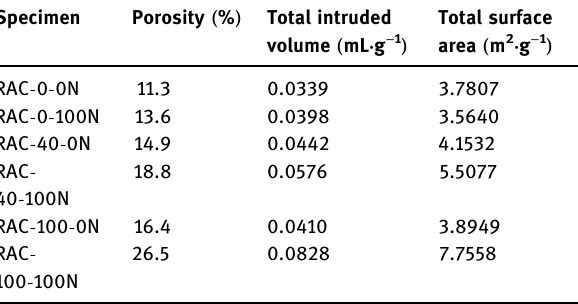
Table 4: Porosity, total pore size, and area of RAC Specimen Porosity ( % ) Total intruded volume ( mL · g − 1